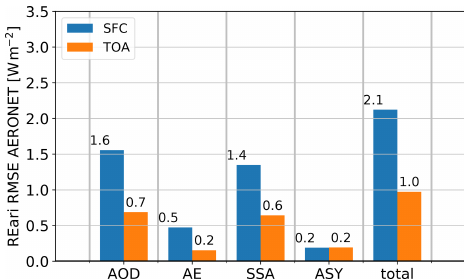
Figure D3. REari kernels weighted by uncertainty estimates of AOD ( ± 0.02), AE ( ± 0.3), SSA ( ± 0.03) and ASY ( ± 0.01) from the AERONET direct and inversion products. The calculations are conducted for the surface (blue) and top of the atmosphere (orange).